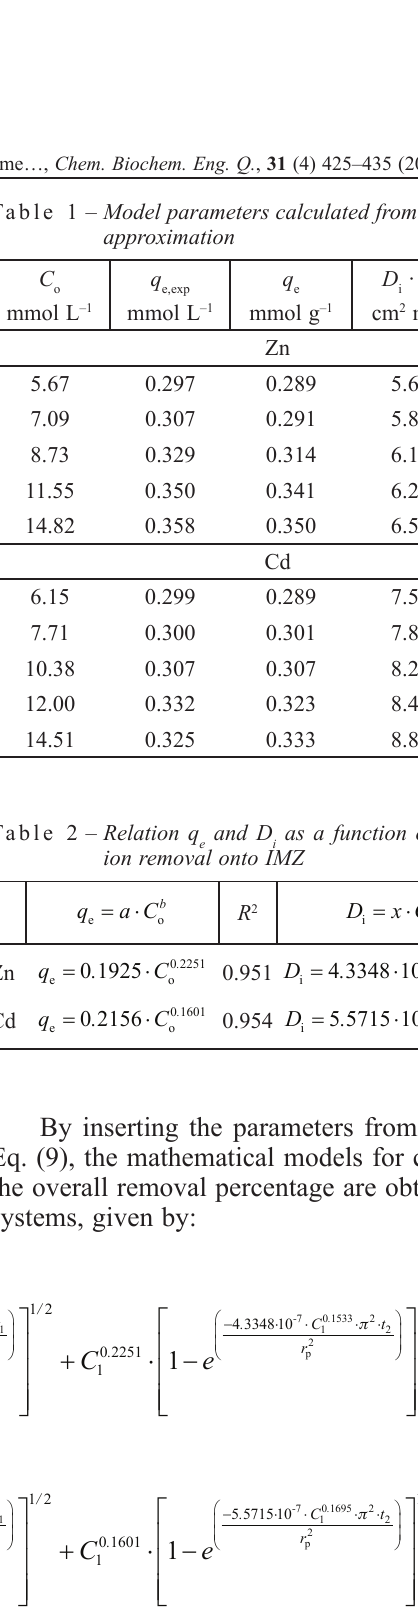
Table 1 – Model parameters calculated from the Vermeulen’s approximation